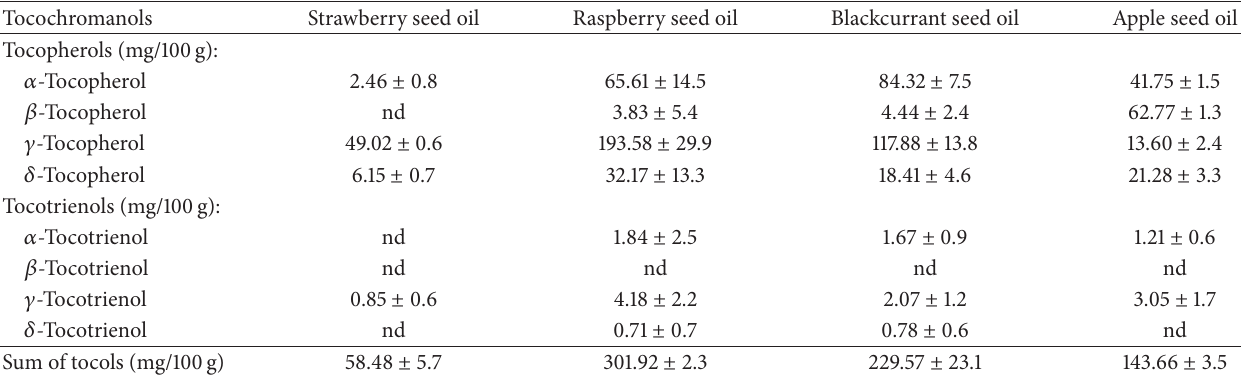
Table 3: Tocochromanol (tocopherol and tocotrienol) content of oils from strawberry, raspberry, blackcurrant, and apple seeds.